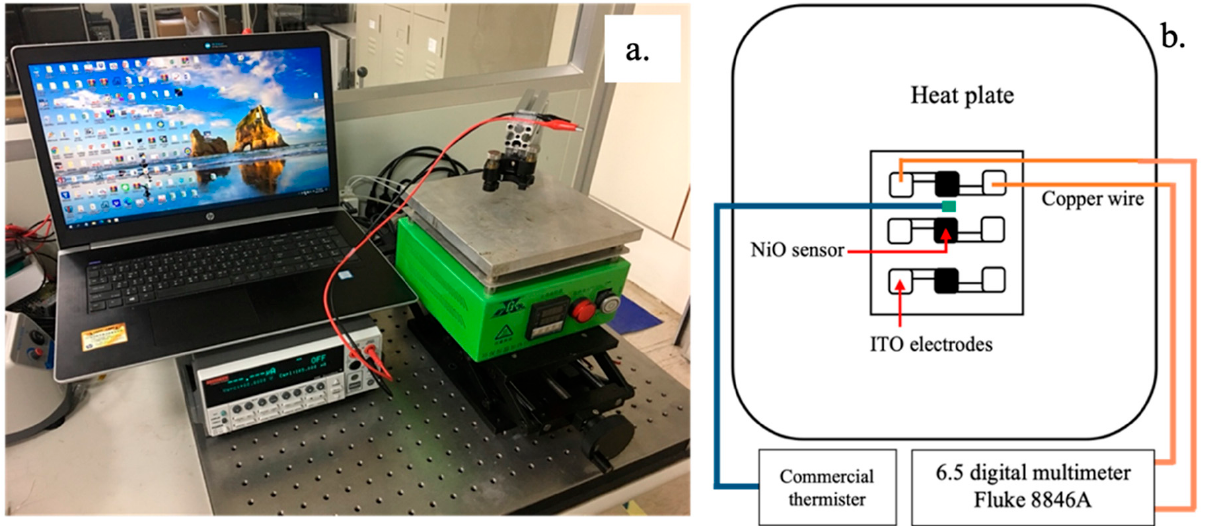
Figure 5. ( a ) Experimental setup for NiO resistance measurement. ( b ) Schematic of measurement setup for NiO thin films characterization.